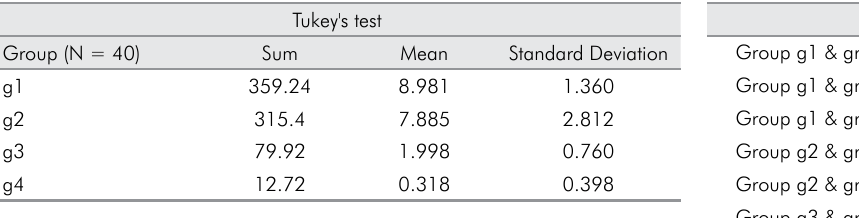
Table 2. Results of the ANOVA and Tukey post-hoc